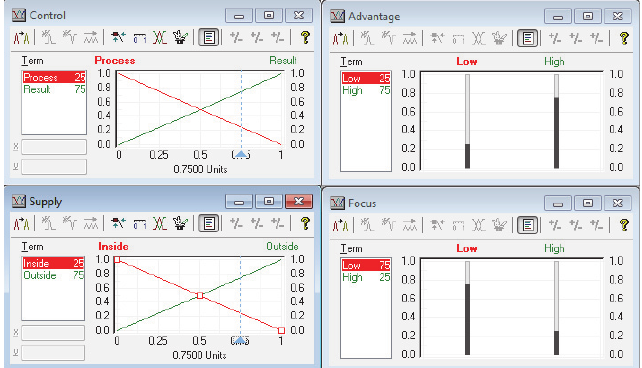
Fig. 8. Studying the results of the alignment of strategies in controlling the relative supply from